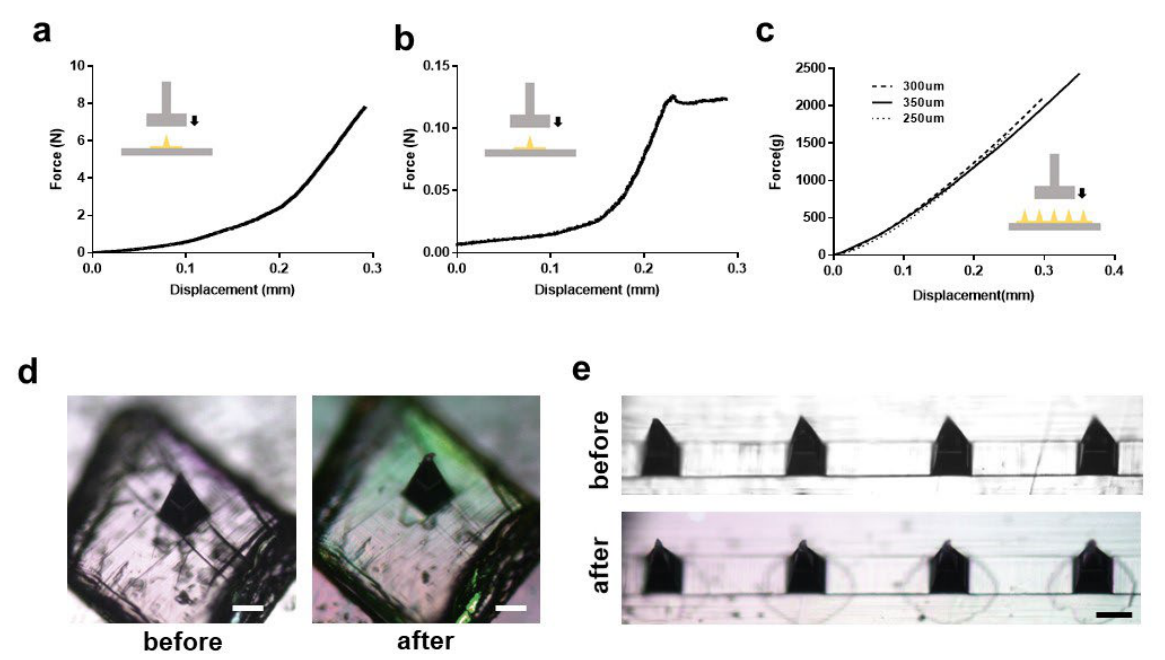
Figure 2. Mechanical characteristics of PLA microneedle. ( a ) Force-displacement curve of single PLA needle. Texture analyzer sensor moved axially at the test speed of 1.2 mm/s with trigger force of 0.003 N. ( b ) Force-displacement curve of single hyaluronic acid-based dissolving microneedle. Same analysis condition was applied. ( c ) Force-displacement curve of PLA microneedle array having various heights of 250, 300, and 350 µ m. ( d ) Single needle compression test with 0.1 N. Scale bar, 125 µ m. ( e ) Compression test of microneedle array with 5 N (0.06 N/needle). Scale bar, 125 µ